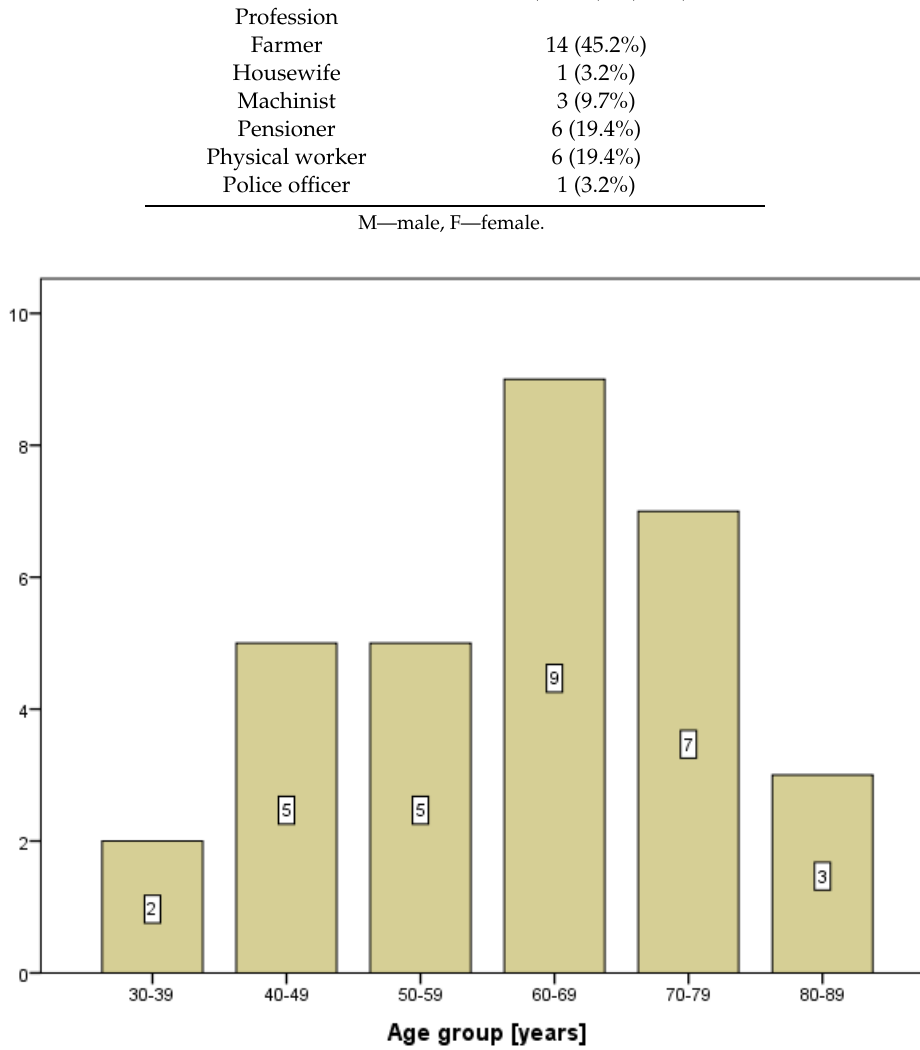
Figure 1. The age distribution of patients with lower lip cancer.